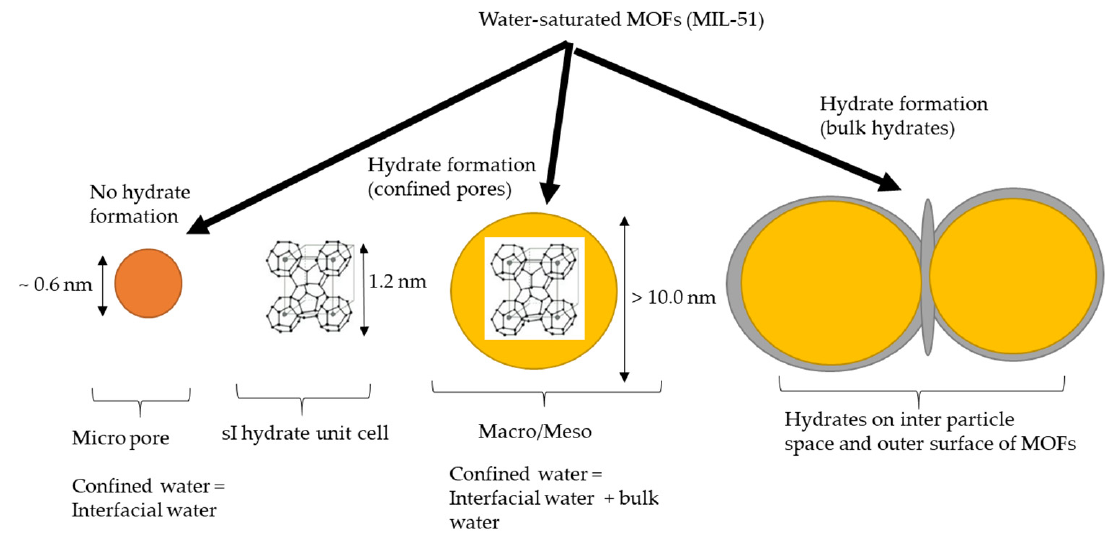
Figure 10. Hydrate formation mechanism in the presence of MOF. Role of surface area and pore size.